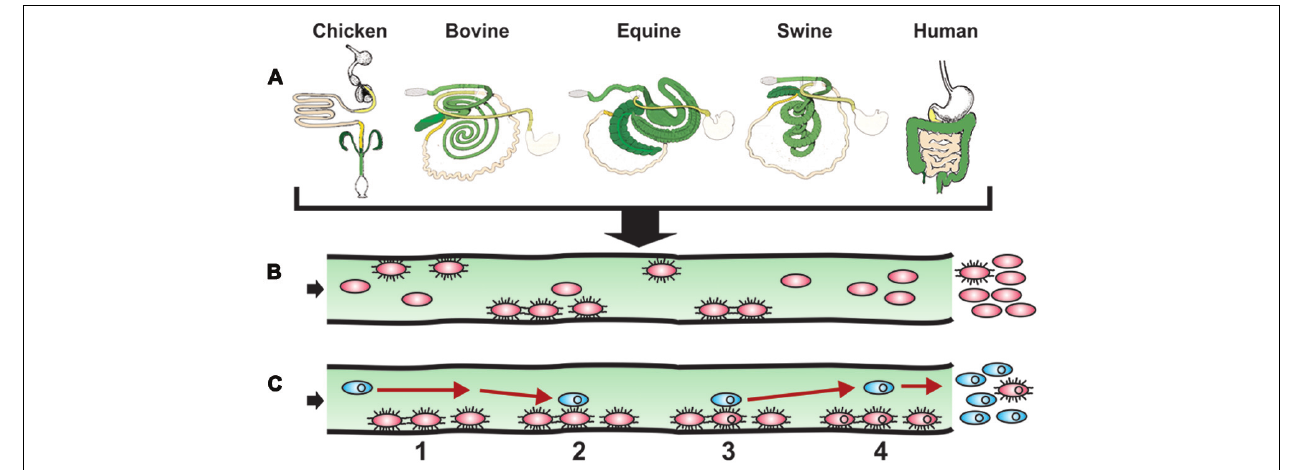
will not be retained as well in the host. A resulting gastroenteritis and/or persistence will result in the multiplication and possible long-term excretion of such Salmonella strains (not shown). (C) Intestinal colonization mediated by specific allelic adhesins of Salmonella (red ovals) optimizes contact (event numbers and time span) with a constant flow of new bacteria (blue ovals), some carrying antimicrobial resistance genes on conjugative or mobilizable elements (small circles in ovals), resulting in increased HGT efficiency and antibiotic-resistant S. enteric a colonizing carrier hosts. With time, excretion of antibiotic-resistant S. enterica will be excreted in greater numbers than antibiotic-susceptible S. enterica (not